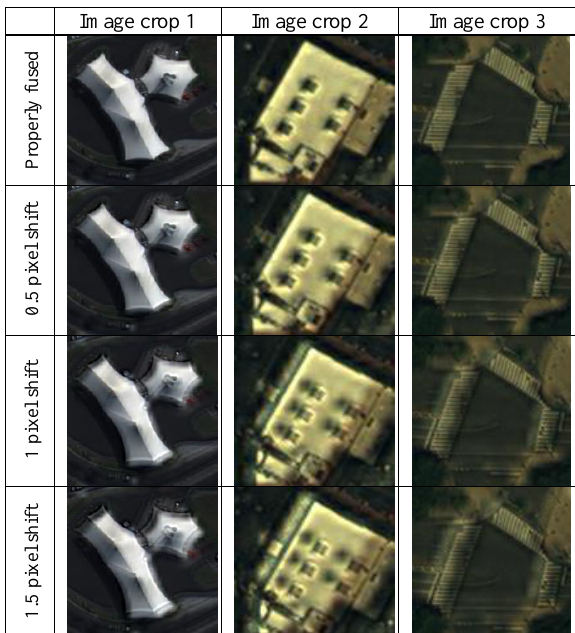
Figure 6. Image crops of error-free and distorted fused images, pan-sharpened by WWI method.